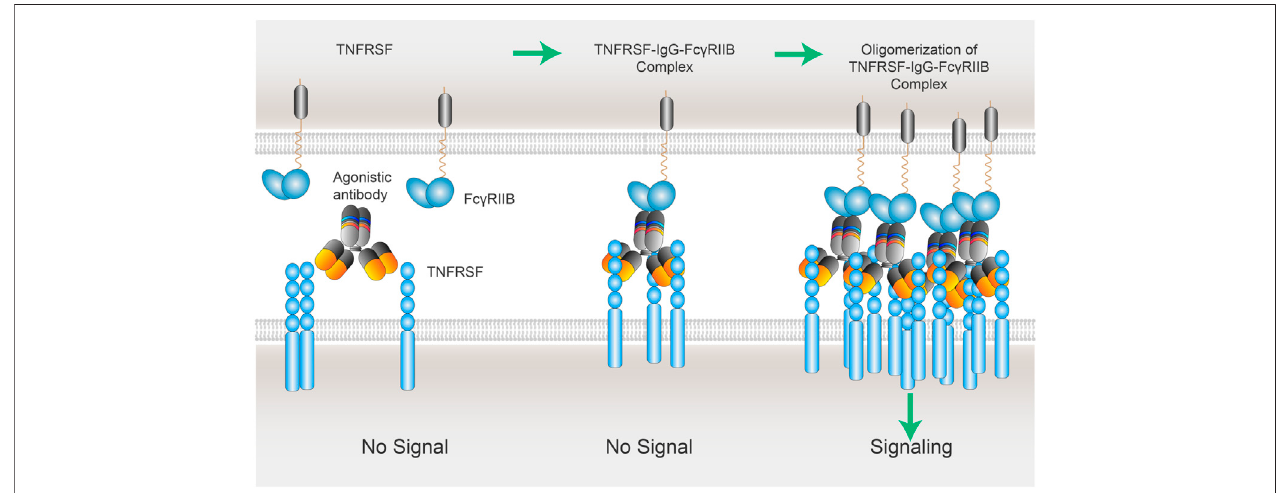
FIGURE 4 | xLinkAb working model: the role of Fc γ RIIB in the oligomerization of TNFSFR-IgG-Fc γ RIIB complexes. xLinkAb TNFRSF agonistic antibody Fab arms binding to TNFRSF is insuf fi cient to cluster and activate TNFRSF target; xLinkAb IgG-TNFRSF complex engages Fc γ RIIB with its engineered Fc selectively for Fc γ RIIB binding, leading to the formation of oligomic TNFRSF-IgG- Fc γ RIIB complexes and clustering of TNFRSF and signaling activation. The initial step should be IgG-Fab binding to TNFRSF, which is followed by TNFRSF-IgG-Fc binding to Fc γ RIIB forming TNFRSF-IgG-Fc γ RIIB complex and secondary clustering of TNFRSF. Activation of TNFRSF signaling depends on the formation of the multivalent TNFRSFs-IgGs-Fc γ RIIBs complexes and TNFRSF